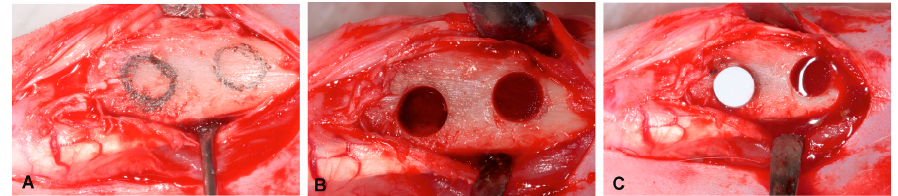
Figure 9. Surgical procedure. ( A ) Tibia after flap removal; ( B ) Preparation of two critical defects of 6 mm diameter located at 4 mm from the top margin with 3 mm of separation between defects; ( C ) biomaterial placement.